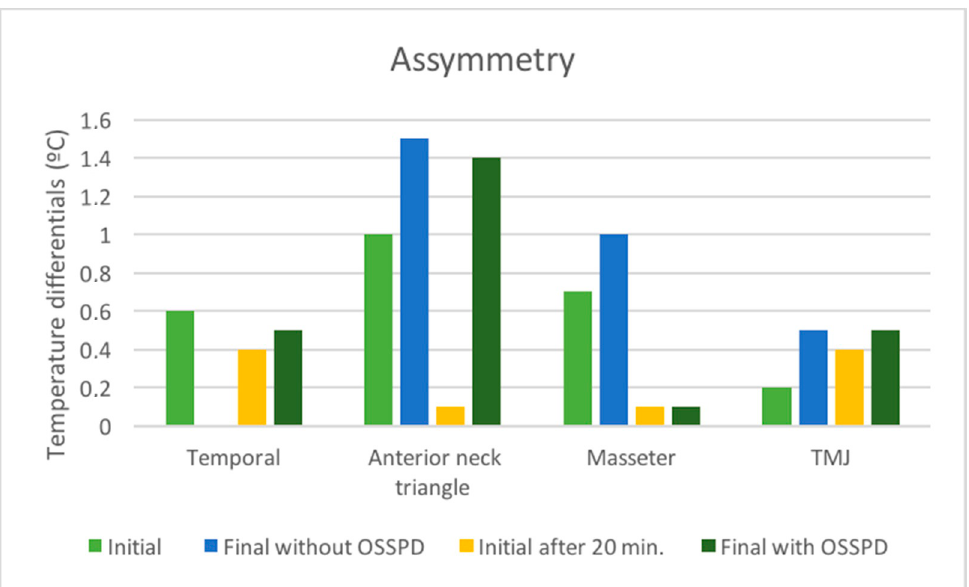
Figure 12. Asymmetry value of contralateral regions of interest (ROIs) in the different times of capture of the thermographic images, initial, final without OSSPD, after the rest of 20 min, and final with OSSPD for the four regions of interest: TMJ, anterior temporal, masseter, and anterior neck triangle.